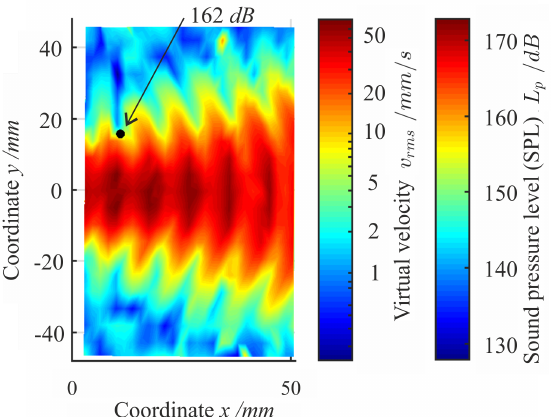
Figure 16. Sound field pattern of standing wave system with concave reflector at distance L = 4 λ ; left colorbar shows measurement of virtual velocity v rms ; right colorbar shows sound pressure level L p after scaling; f = 21.4 kHz; ˆ x = 19 µ m.